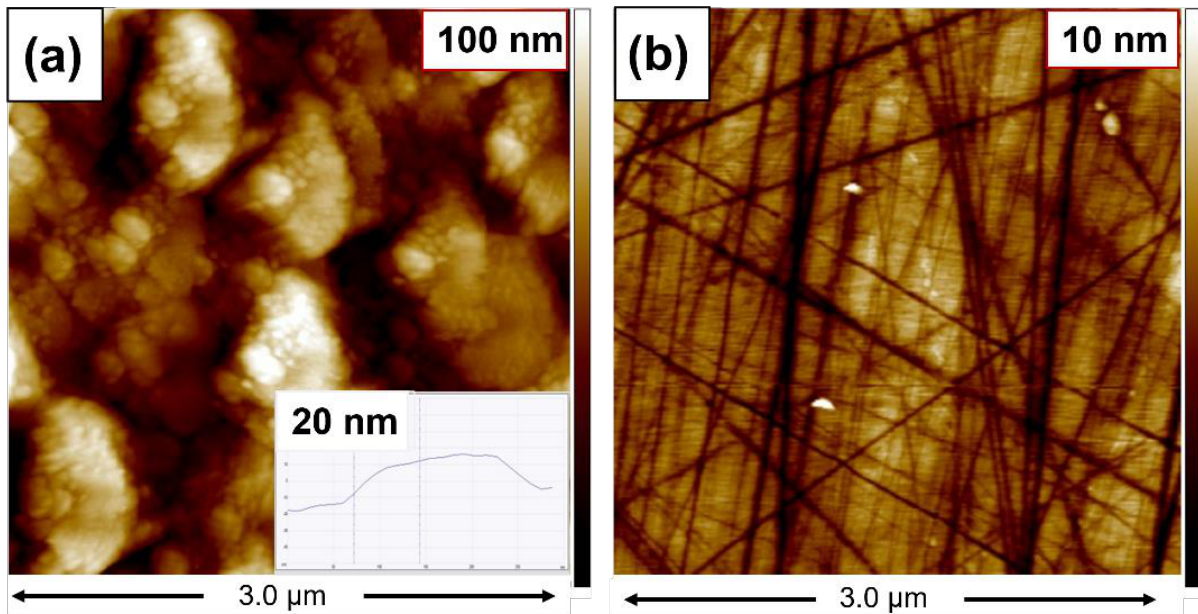
Figure 5. AFM measurements: ( a , b ) show the AFM images taken in graphene growth on SiC and on the SiC substrate, respectively.